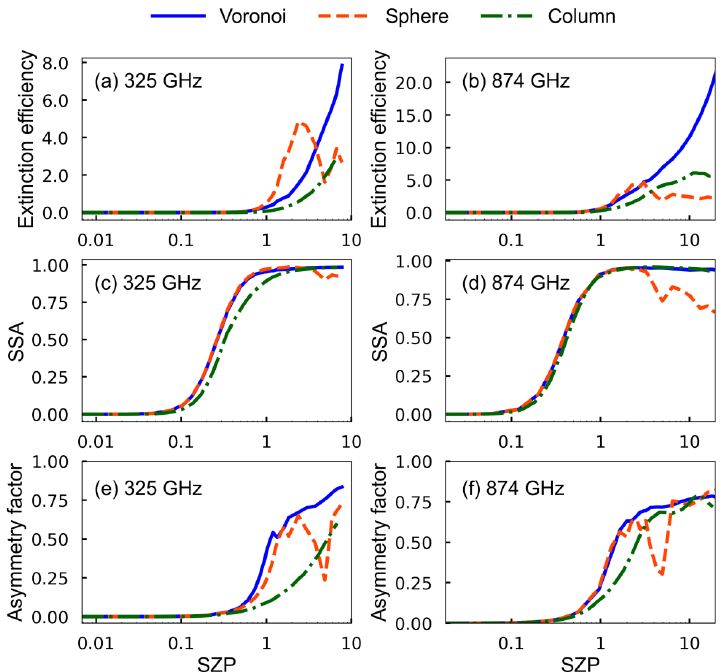
Figure 2. The extinction efficiency, single-scattering albedo, and asymmetry factor as functions of the SZP for the Voronoi (solid blue line), sphere (dashed red line), and column (dashed green line) ICS models with a refractive index of 1 . 78 + 0 . 005 i in the (a, c, e) 325GHz and